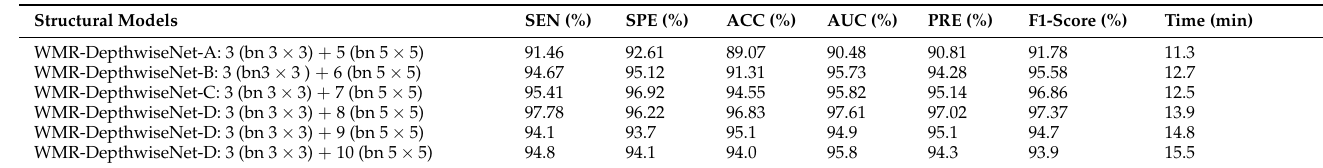
Table 5. Performance evaluation of the structural configuration of our proposed model with different depthwise bottleneck modules for for CT dataset. bn represents the bottleneck module. Structural